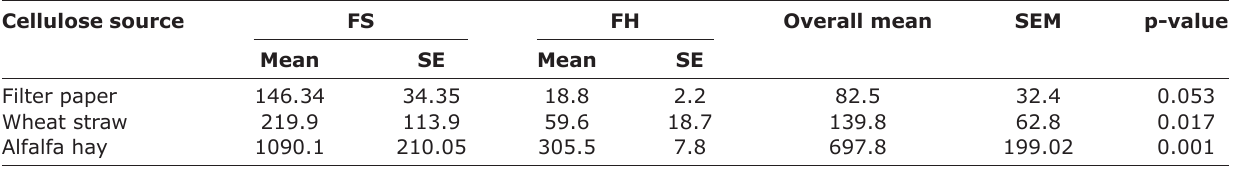
Table-7: Cellulase (endo-cellulase) activity (mU/mL) (mean±SD) of rumen bacterial community of the dromedary camel fed different forages using different cellulose sources. Cellulose source